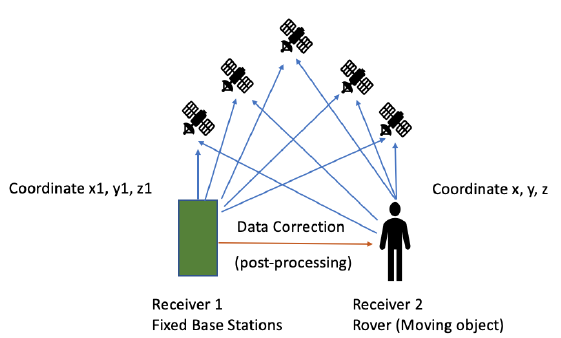
Figure 6. How differential GPS (DGPS) works as presented in Reference [40].